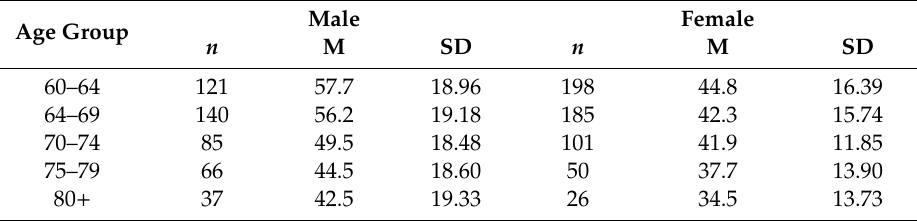
Table 12. Two-minute steps based on age group and gender, Unit: reps. Age